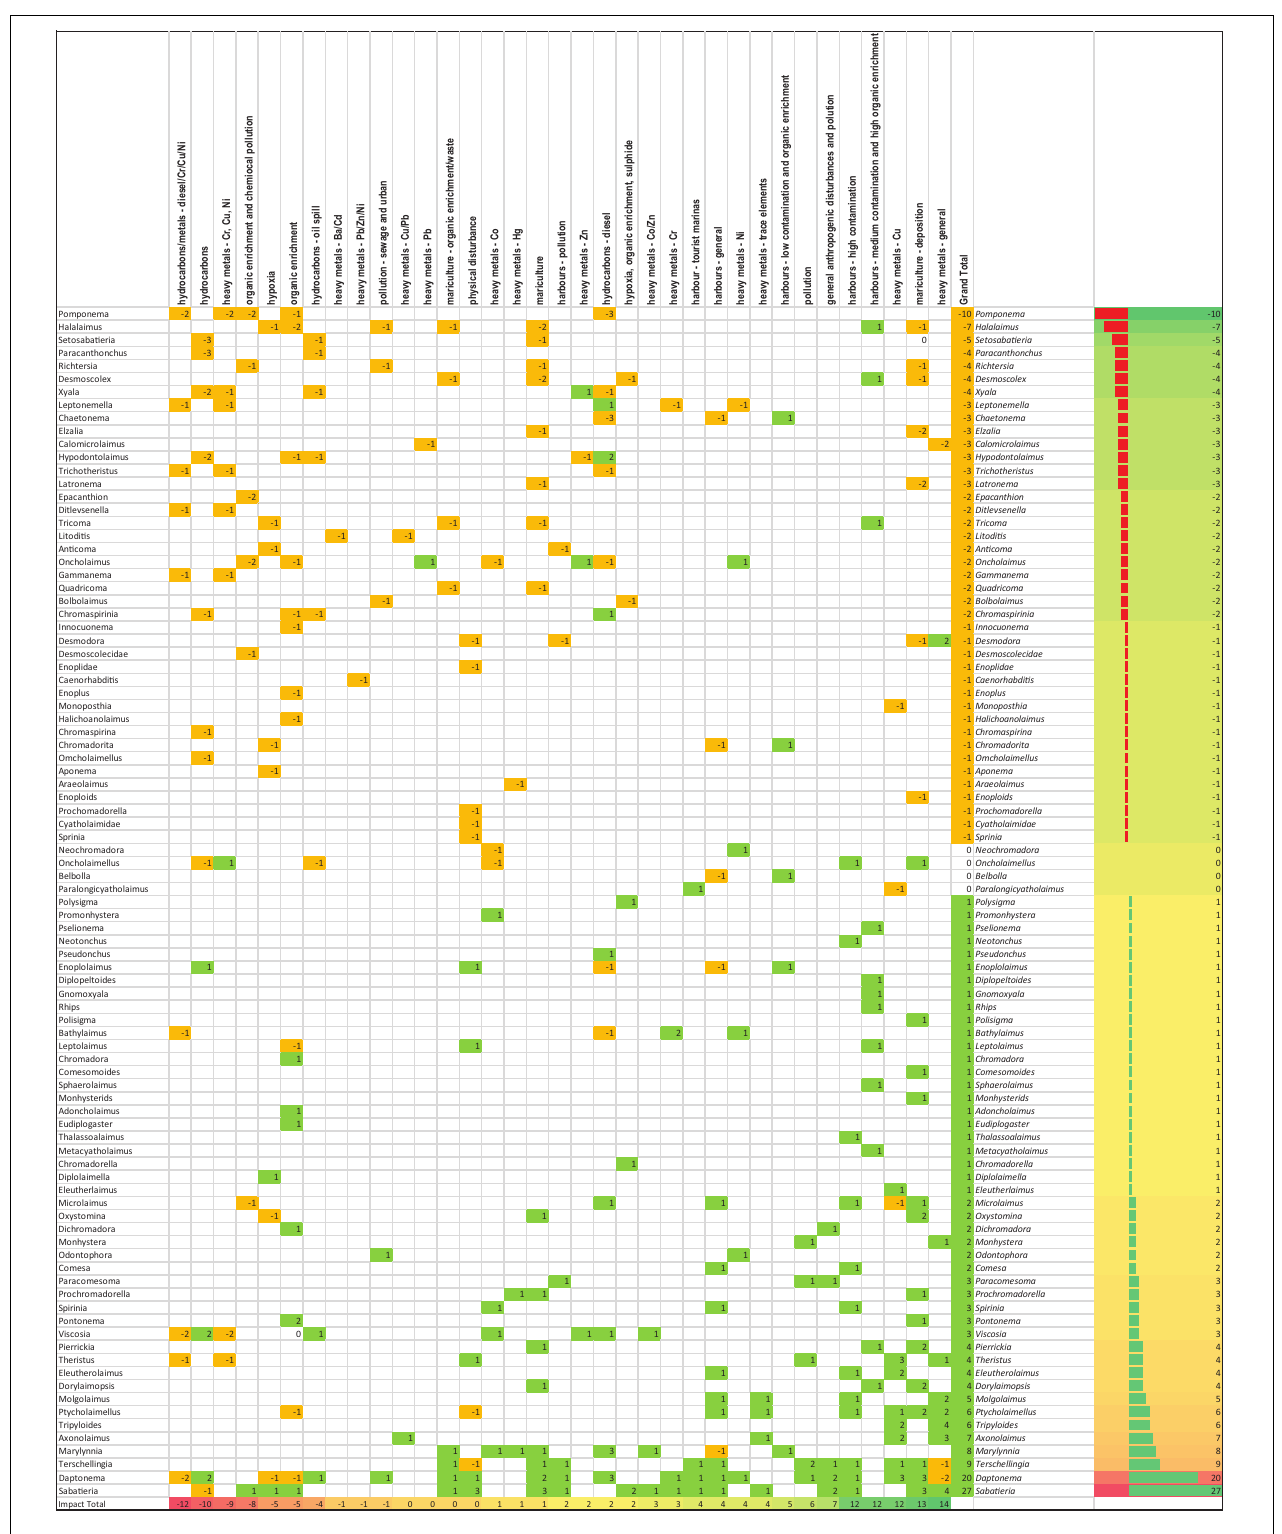
FIGURE 1 | Nematode taxa responses to disturbances and perturbations. 35 different categories of pollution and disturbances were identified from papers specifically referencing the disturbance types. All taxa were scored based on a resistance/sensitivity framework. When a taxon was identified as resistant to a certain disturbance, a value of + 1 was awarded, and when a taxon was denoted as sensitive it was awarded a value of − 1. Positive and negative values were color-coded (green for positive, yellow for negative), and scores were summed for all taxa. Taxa with scores well above 0 are the most resistant to anthropogenic stressors, while scores below 0 denote taxa that are very much sensitive to